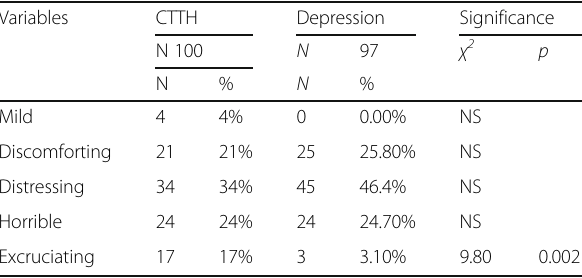
Table 2 Pain severity in patients with CTTH and patients with